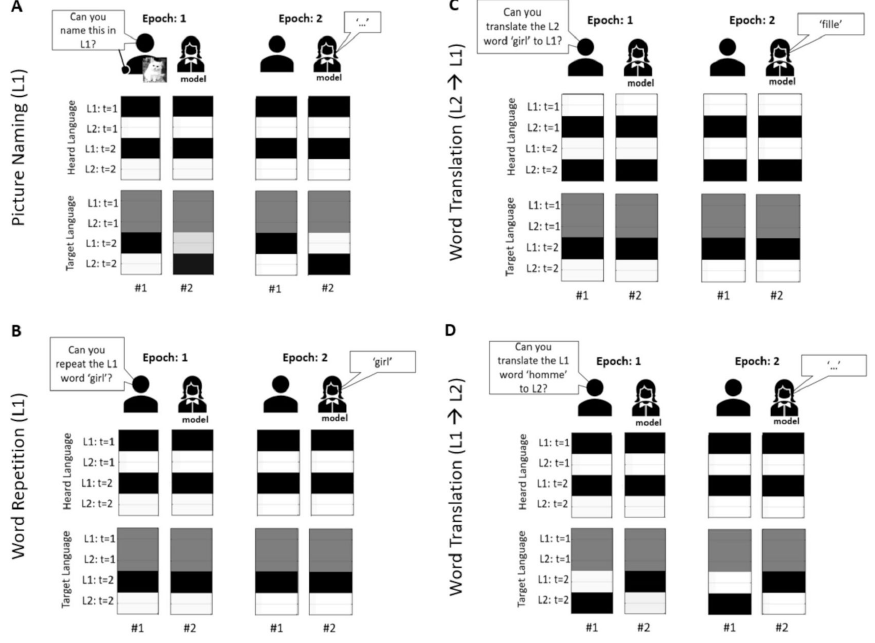
Figure 5. (belief updates) Each figure ( A – D ) reports belief updating, over two epochs of a single trial, for the two subjects: #1-control and #2-lesioned. These are shown for the target language and heard language factors when completing di ff erent tasks during the simulated day 3, when the model had access to L2. These tasks are picture naming in L1 ( A ), word repetition in L1 ( B ), word translation from L2 to L1 ( C ) and word translation from L1 to L2 ( D ). For each figure, the top row comprises an image showing the stage of the trial and the bottom two rows display the belief updates for heard and target language. The columns represent the two epochs for the two models. The first column represents the posterior expectations about each of the associated states at di ff erent epochs (current, future) at epoch 1, for subjects #1 and #2. Similarly, the second column represents the posterior expectations about each of the states at di ff erent epochs at epoch 2. For example, for the target language factor, in both panels there are 2 states, and a total of 2 × 2 (states times epochs) posterior expectations. Similarly, for the heard language factor there are two levels, and total of 2 × 2 expectations. Note that white represents an expected probability of zero, black of one, and grey indicates gradations between these extremes. For example, the first column, top row in A corresponds to expectations about the heard language in terms of two alternatives for the first epoch. The second column, top row reports the equivalent expectations for the second epoch. This means that at the beginning of the trial the second column reports beliefs about the future; namely, the next epoch. However, later in time, these beliefs refer to the past, i.e., beliefs currently held about the first epoch as seen in the second column. This aspect of (deep temporal) inference is e ff ectively an implementation of working memory that enables our model to remember what it has heard—and accumulate evidence for the target language that is subsequently articulated; i.e., mediating a working memory for planning short-term responses. Note that most beliefs persist through time. For example, the heard language reveals itself almost immediately and this prospective belief is propagated into the